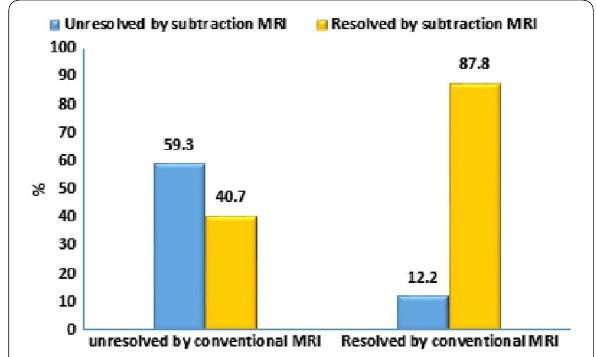
Fig. 2 The degree of agreement between the two readers and the additive value of subtraction technique to the dynamic MRI